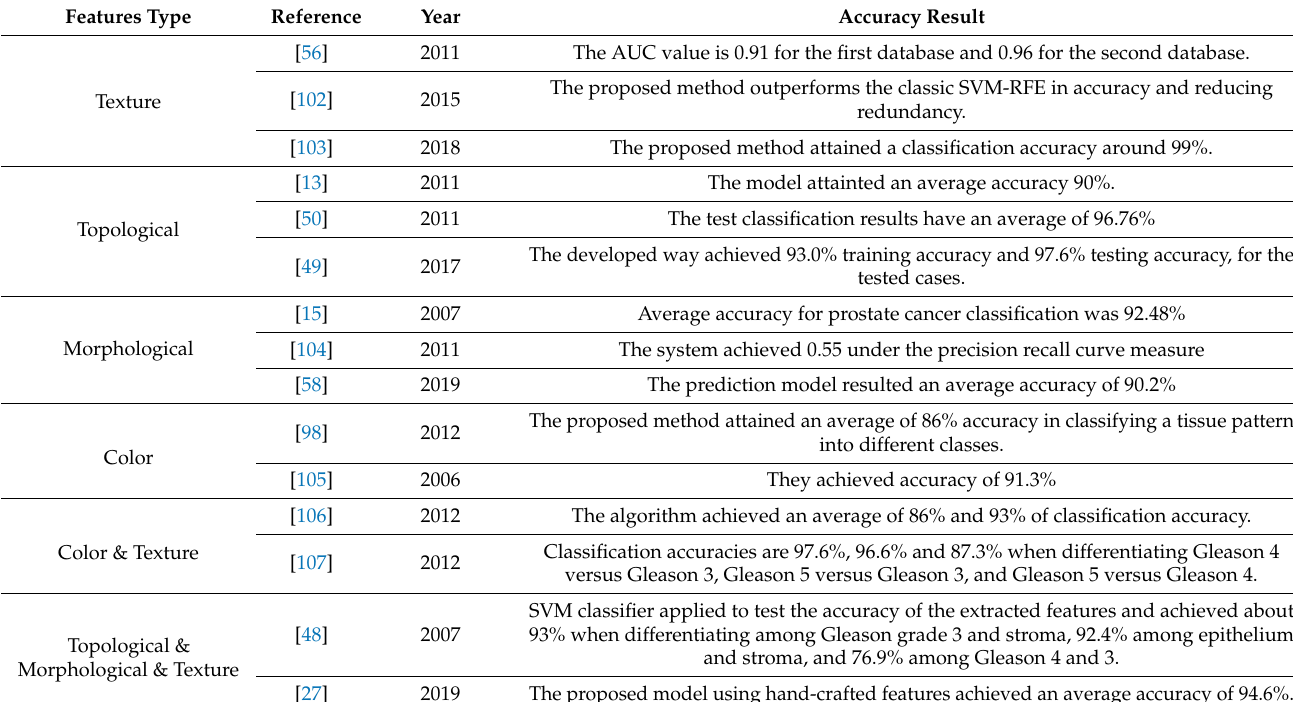
Table 3. Summary of publications focused on feature selection of prostate histopathology